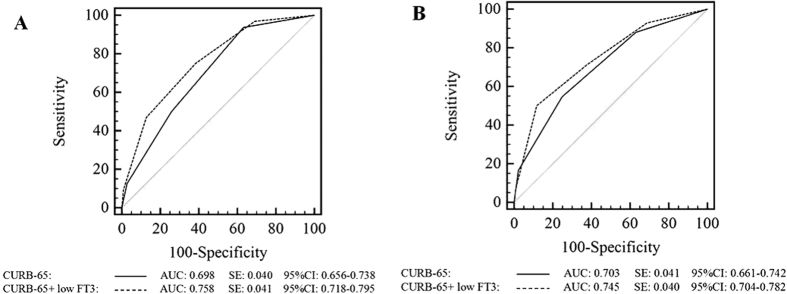
ROC curves for CURB-65 and low FT3 + CURB-65 for 30-day mortality (A) and ICU admission (B).